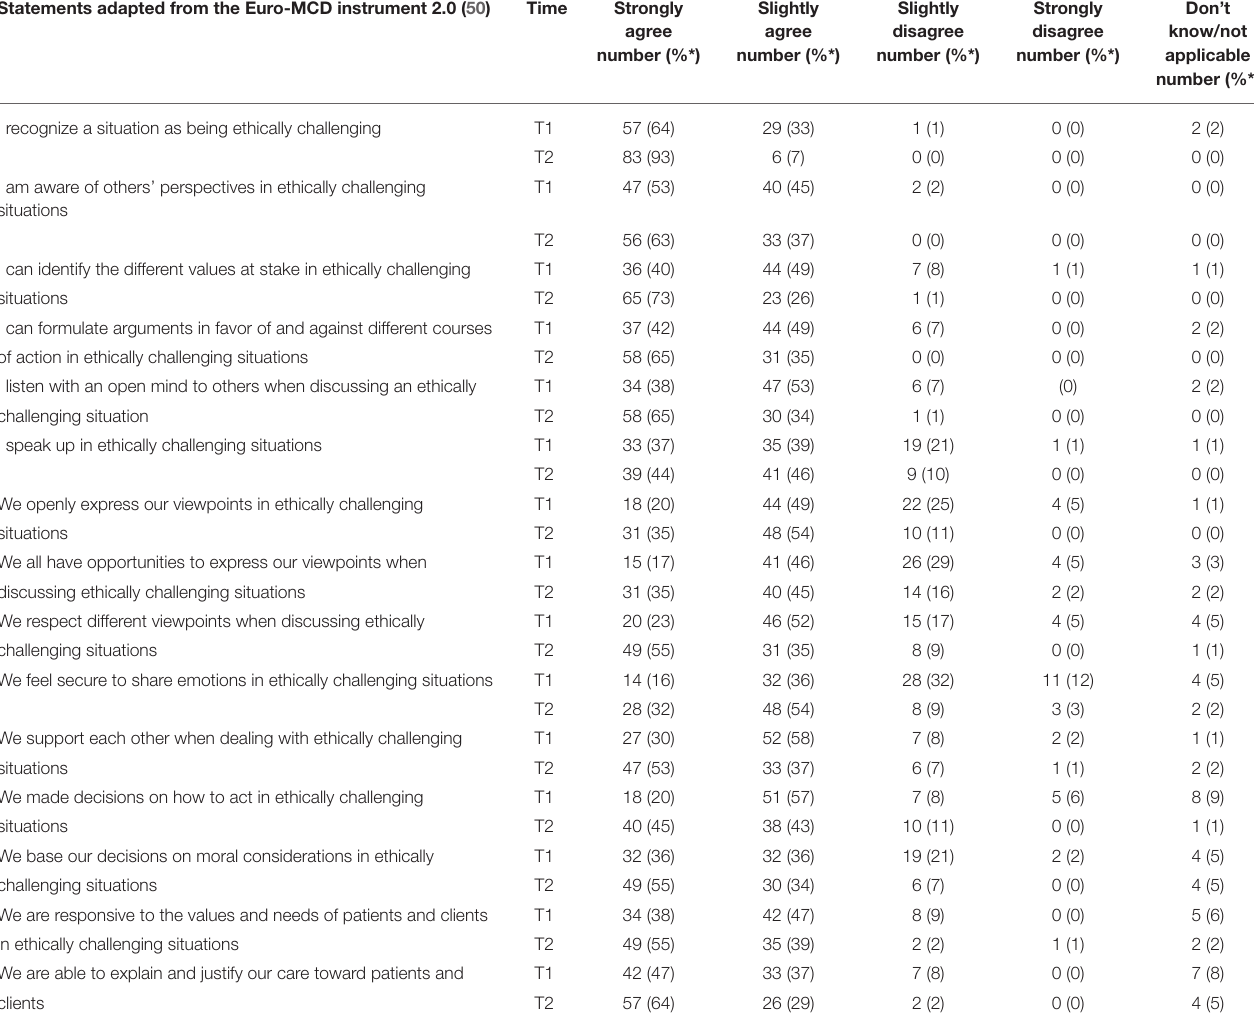
TABLE 4 | Frequency table for responses to statements adapted from the Euro-MCD instrument (2.0) from respondents prior to (T1) and following (T2) participation in virtual ethics rounds ( n = 89). Statements adapted from the Euro-MCD instrument 2.0 (50) Time Strongly